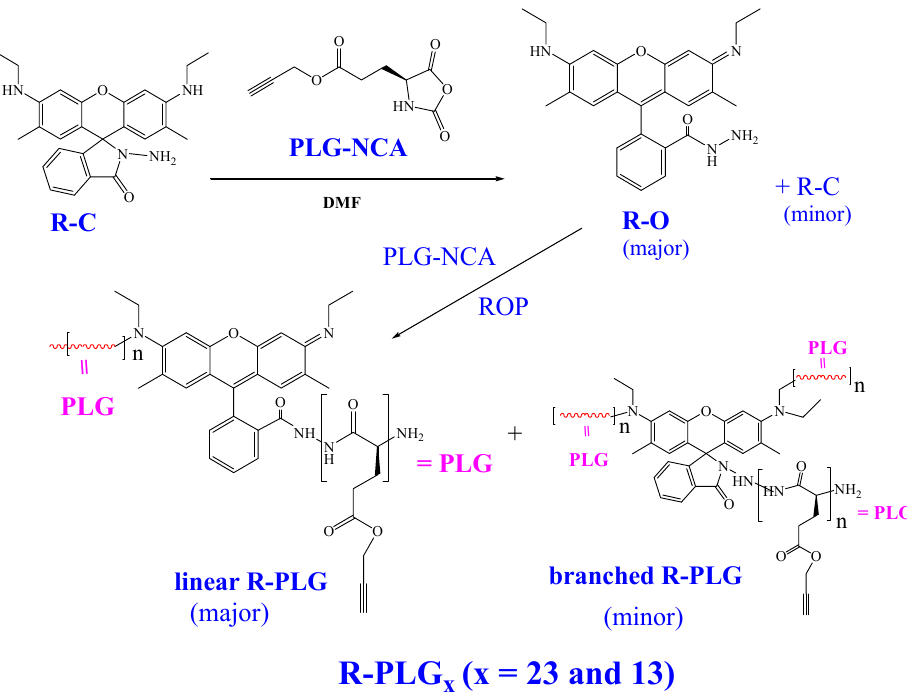
Scheme 2. Conversion of ring-close R-C to ring-open R-O by cyclic peptide monomer PLG–NCA